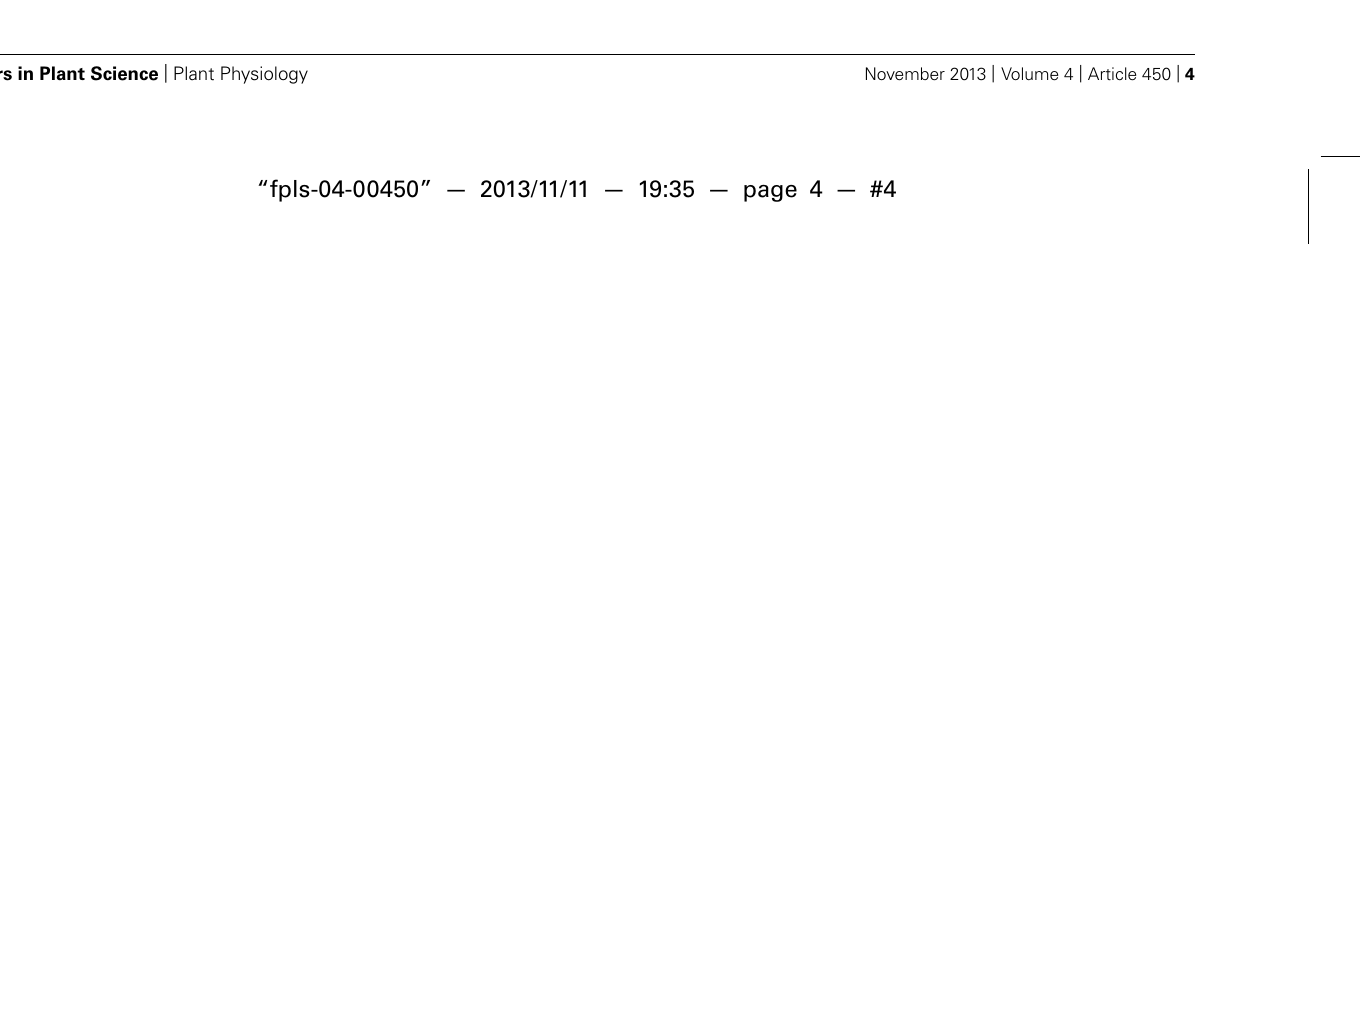
FIGURE 3 |The catalytic sites of rice cytoplasmic GAPDH and non-phosphorylating GAPDH from Streptococcus mutants. (A) Magnified representation of OsGAPC catalytic site (PDB code 3E5R). Important catalytic residues, the cofactor NAD + and residue Cys-158 are shown as ball-and- sticks.The distances of the sulfur atom (SG) of catalytic Cys-154 from the